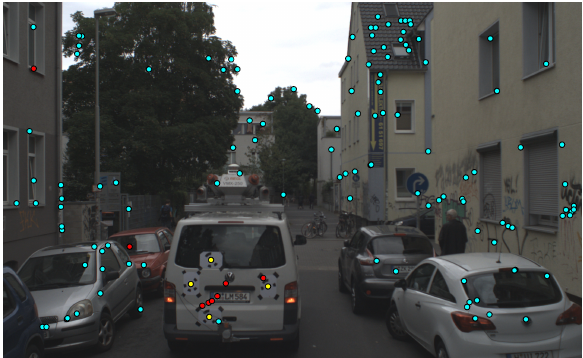
Figure 6. Image taken by the trailing vehicle at a point in time between anchor point 12 and 13; the front vehicle can be seen in the centre of the image. Yellow: observed marker points. Blue: observed tie point. Red: tie points eliminated as outliers.